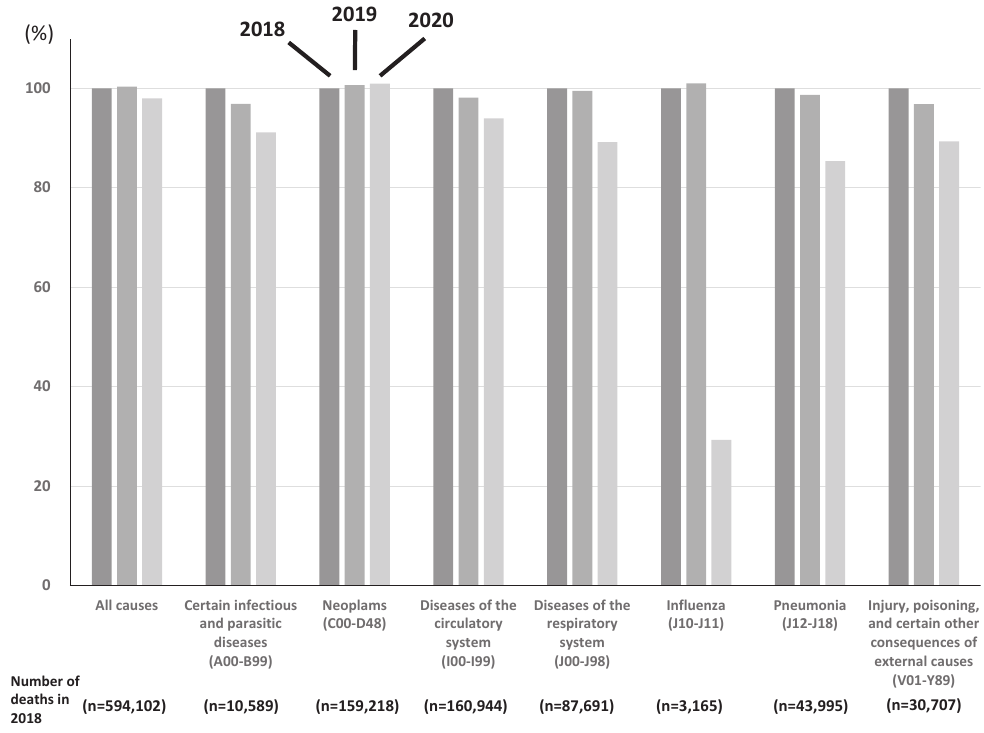
Figure 3. Percent change relative to cumulative number of mortality from January to May in 2018 separated by selected causes of death during the period from 2018 to 2020 in Japan. ICD-10 (International Classi fi cation of Diseases 10th Revision) codes are shown in the parentheses. Numbers of deaths from January to May in 2018 are also shown in the